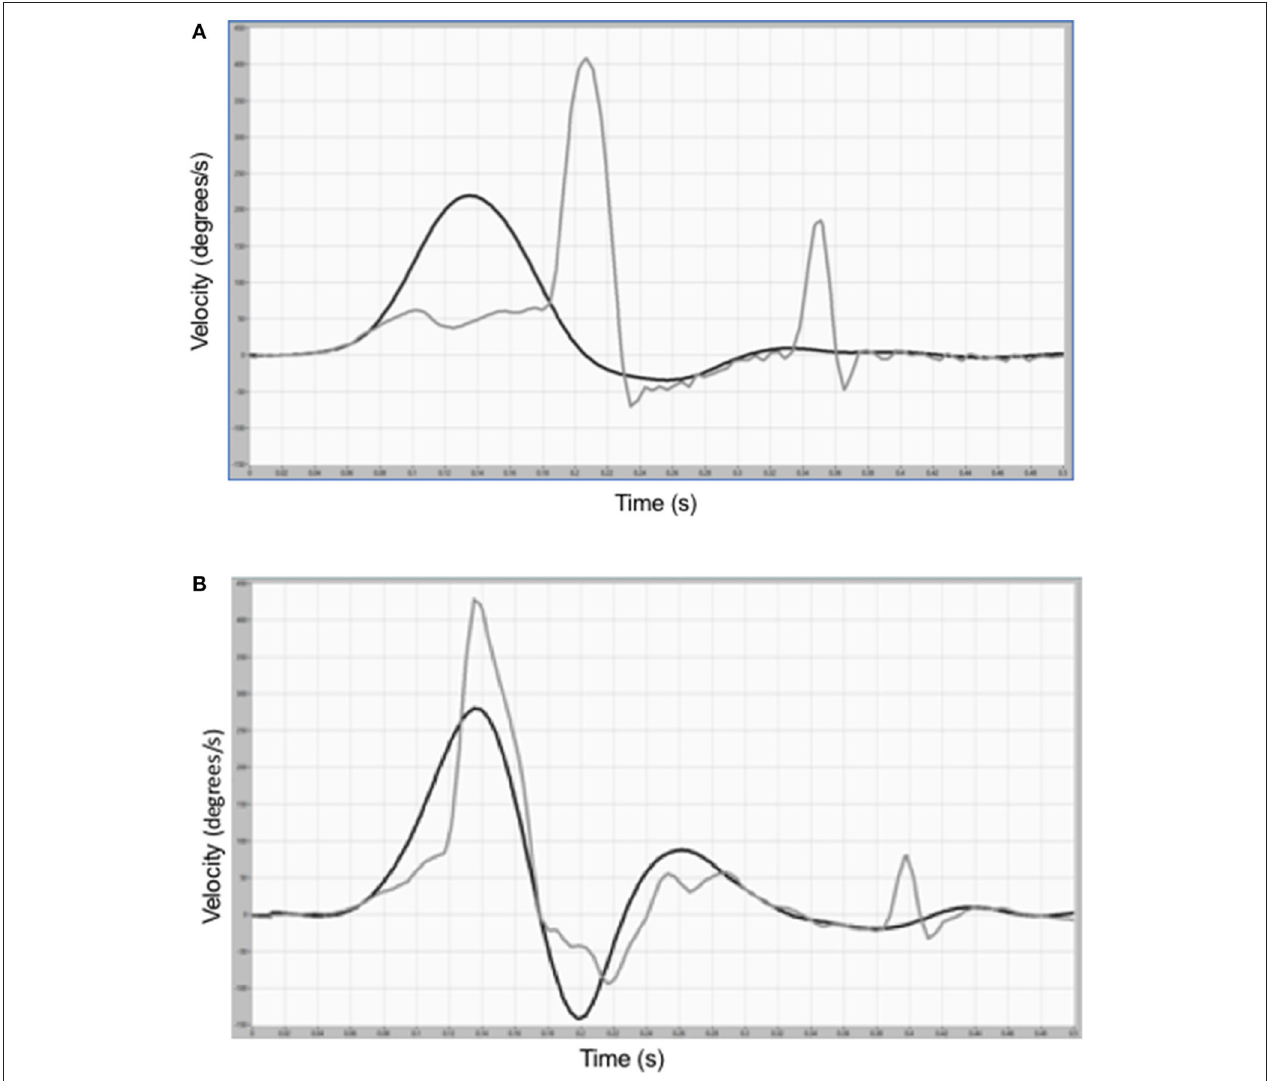
FIGURE 1 | (A) Eye and head velocity traces during a conventional, passive head-impulse test toward the ipsilesional side in one representative subject show low eye velocity during the head movement and late covert saccade (after 135ms) and an overt compensatory saccade. (B) Eye and head velocity traces in the same subject during an active head rotation toward the ipsilesional side show a large early (after 60ms) covert saccade that occurs during the head movement.